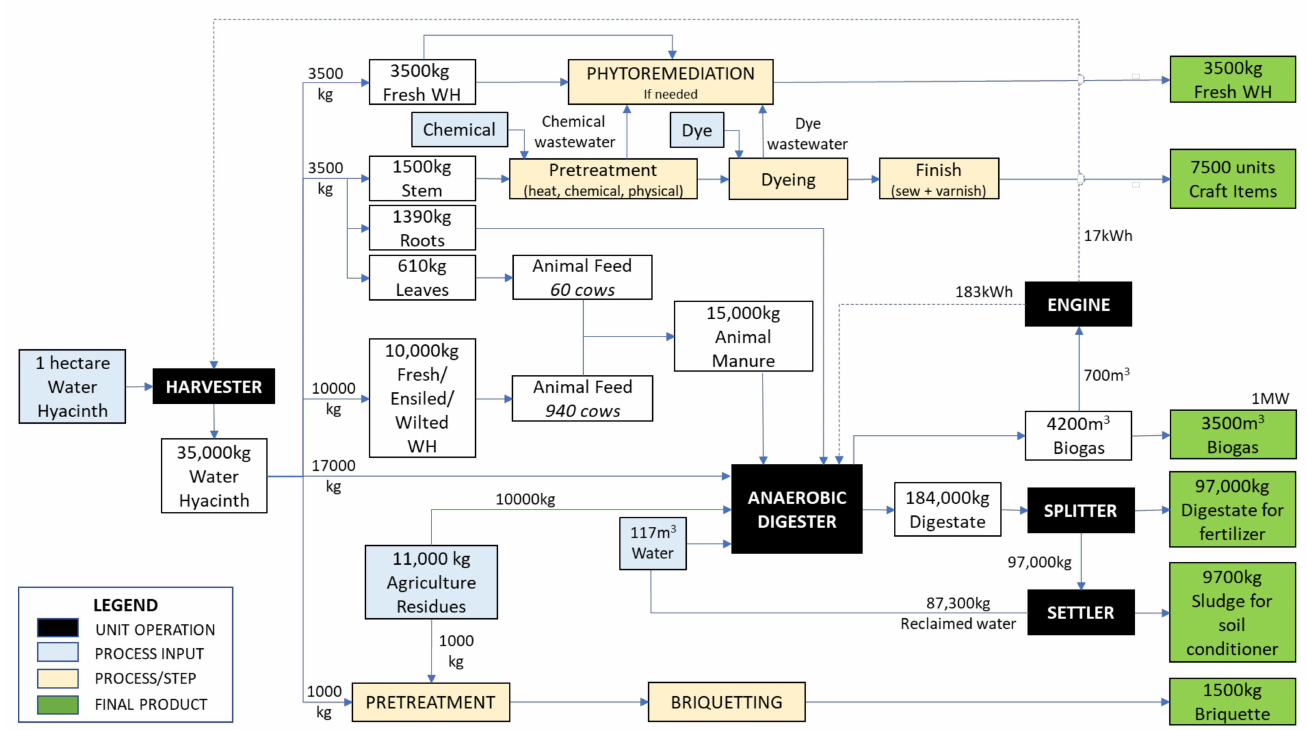
Figure 7. The proposed model for the valorisation of water hyacinth into bioproducts, utilising agricultural residues, reclaimed water and technologies that can be readily adopted by rural